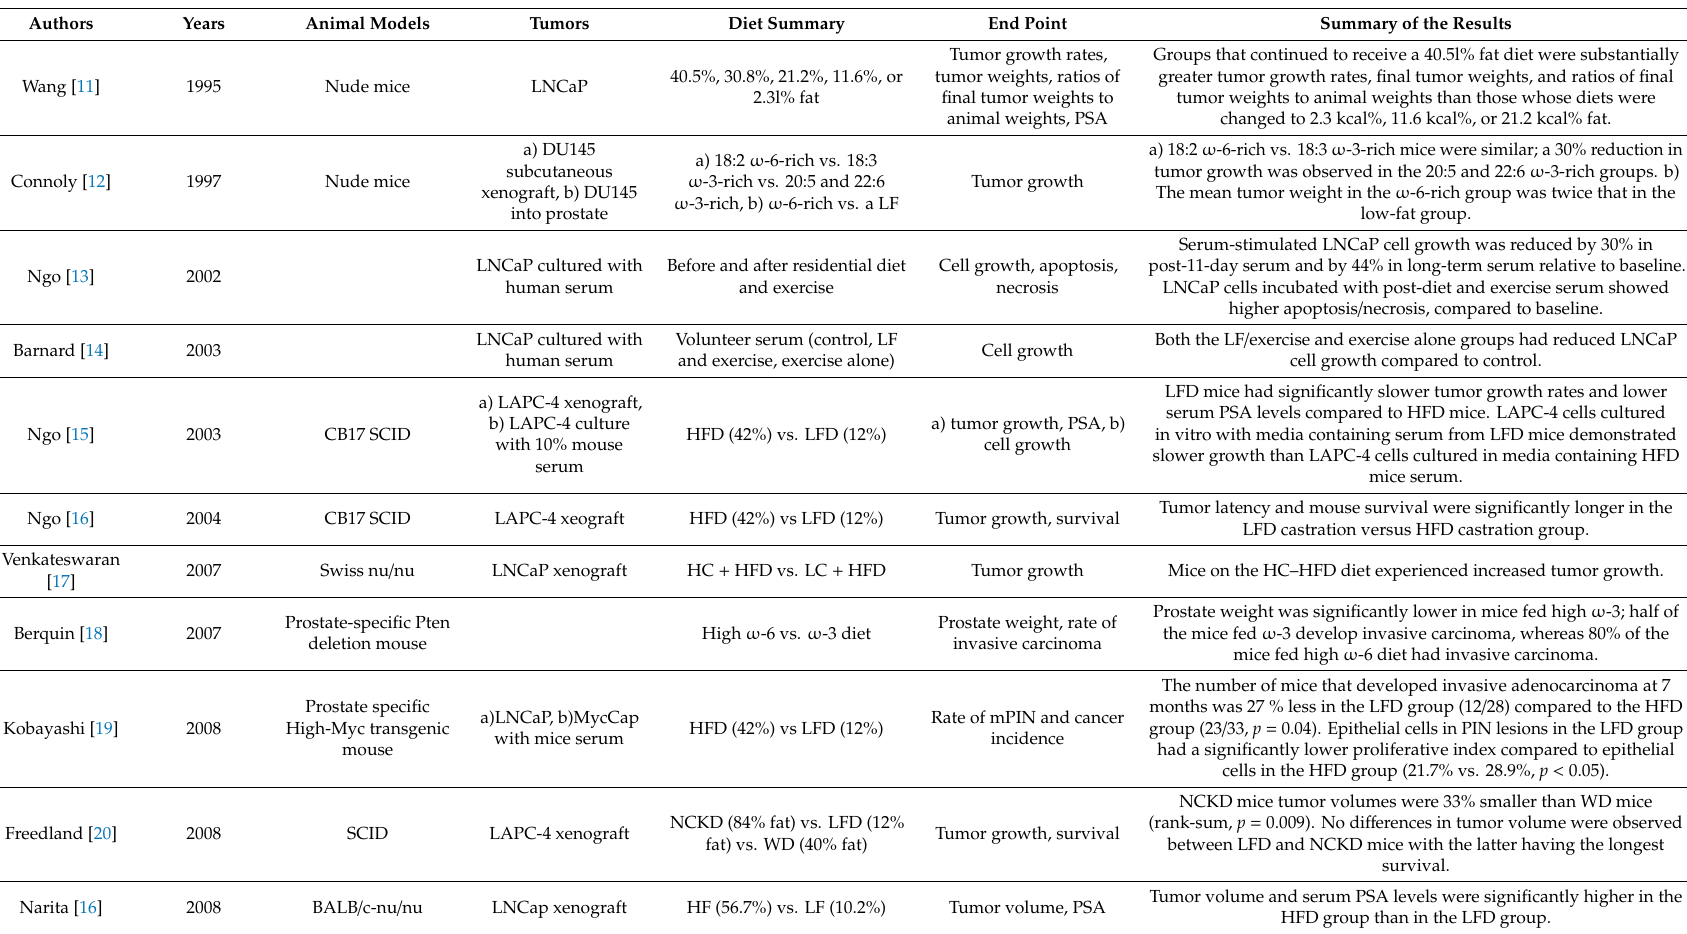
Table 1. Summary of preclinical models on dietary-fat induced prostate cancer development and